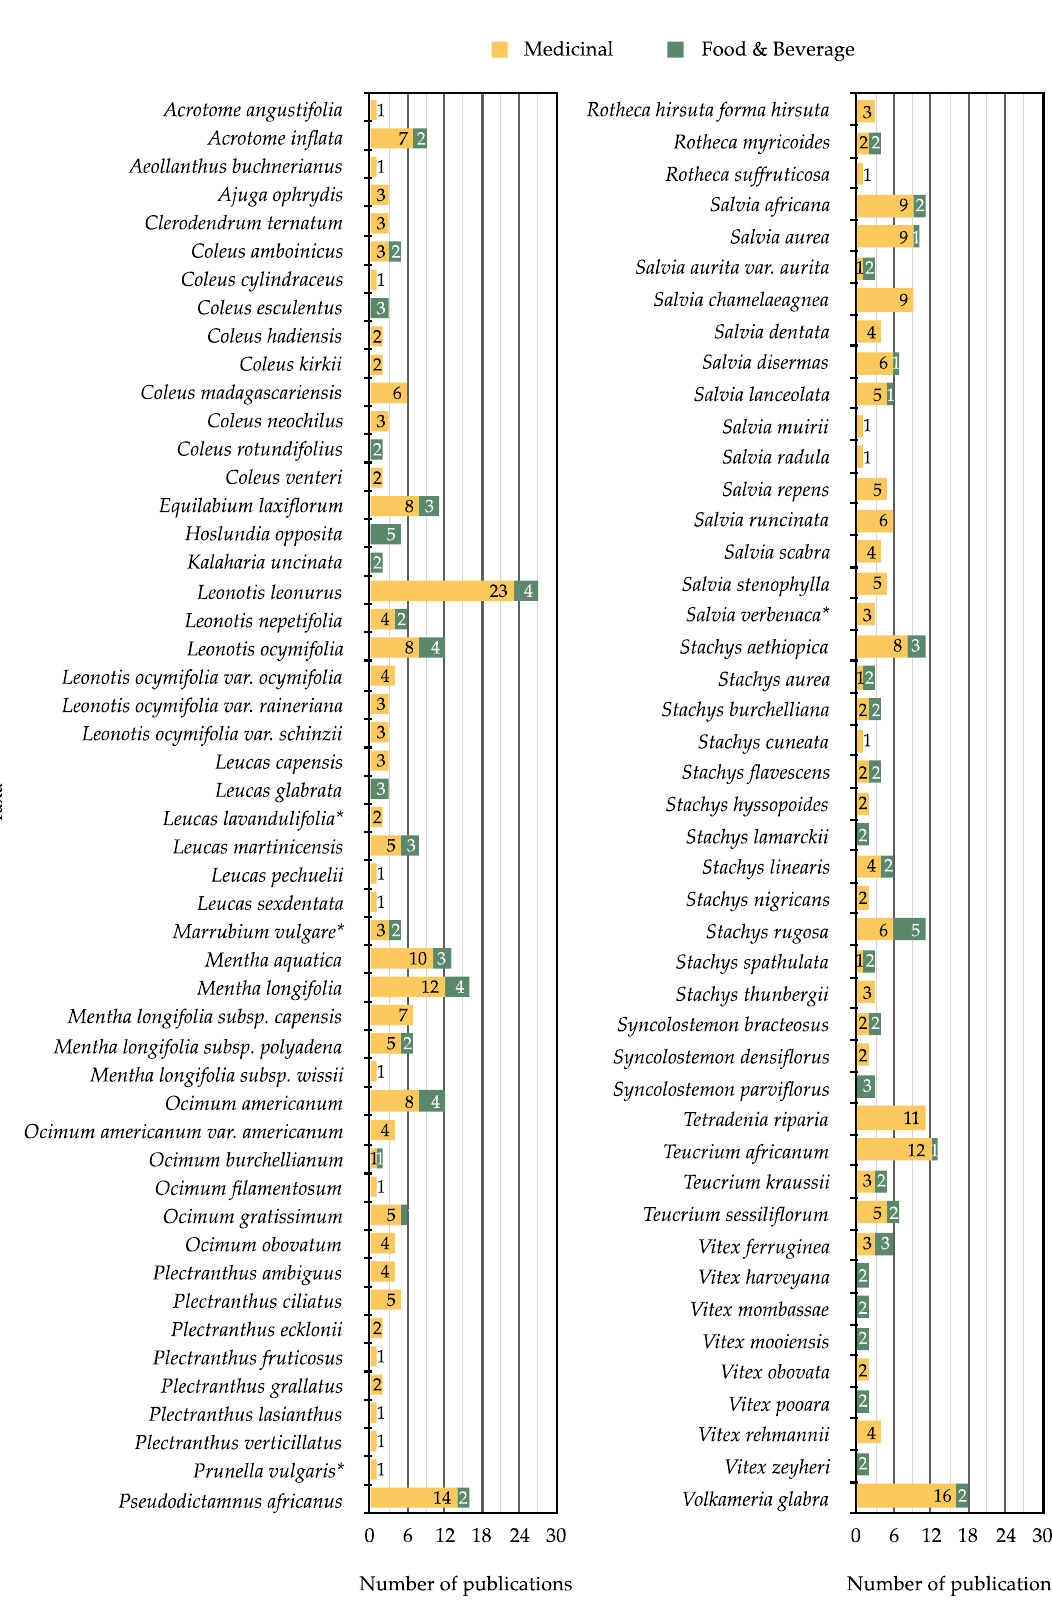
Figure 7. The numbers of publications where medicinal (yellow) and food and beverage (green) uses have been recorded for southern African genera and species of Lamiaceae.